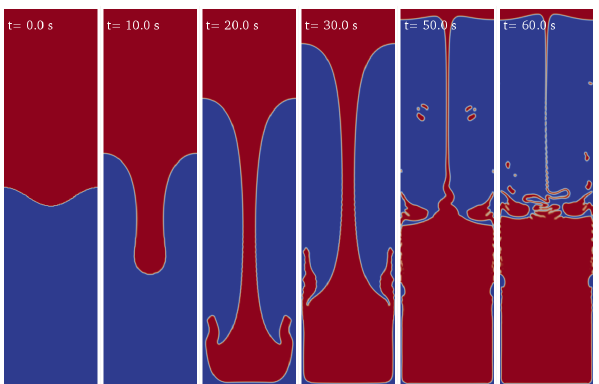
Figure 6. Rayleigh–Taylor instability between a volatile-rich = 2wt%) basalt (bottom) and andesite (top) computed with ( X H 2 O the OpenFOAM solver interFoam (color-coded). The physical domain size is 1m ×